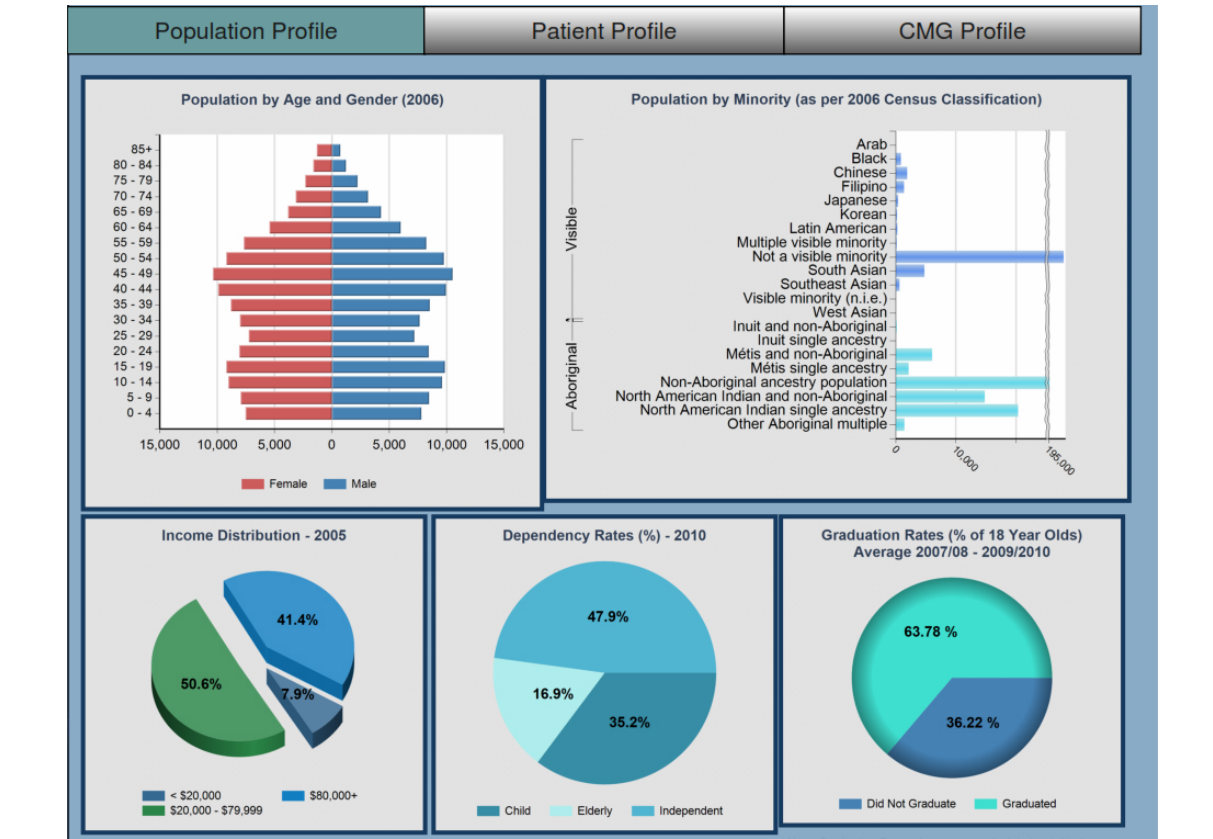
Figure 3. Main dashboard: Population